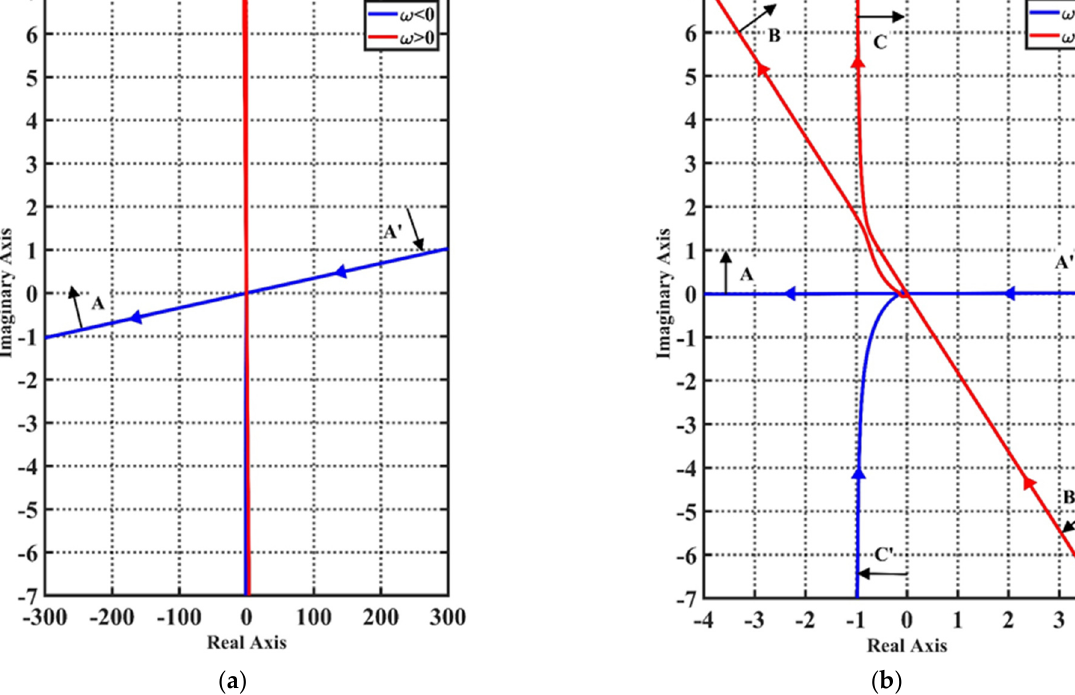
Figure 11. Inverse Nyquist diagram for Ω = 550 rad/s when Z s = − 0.3 mm. ( a ) Global; ( b ) Local. The inverse Nyquist curve turns 180 (cid:2925) clockwise from A to A (cid:4593) , B to B (cid:4593) and C to C (cid:4593) with infinite radii. Thus, it circles (−1,j0) once.